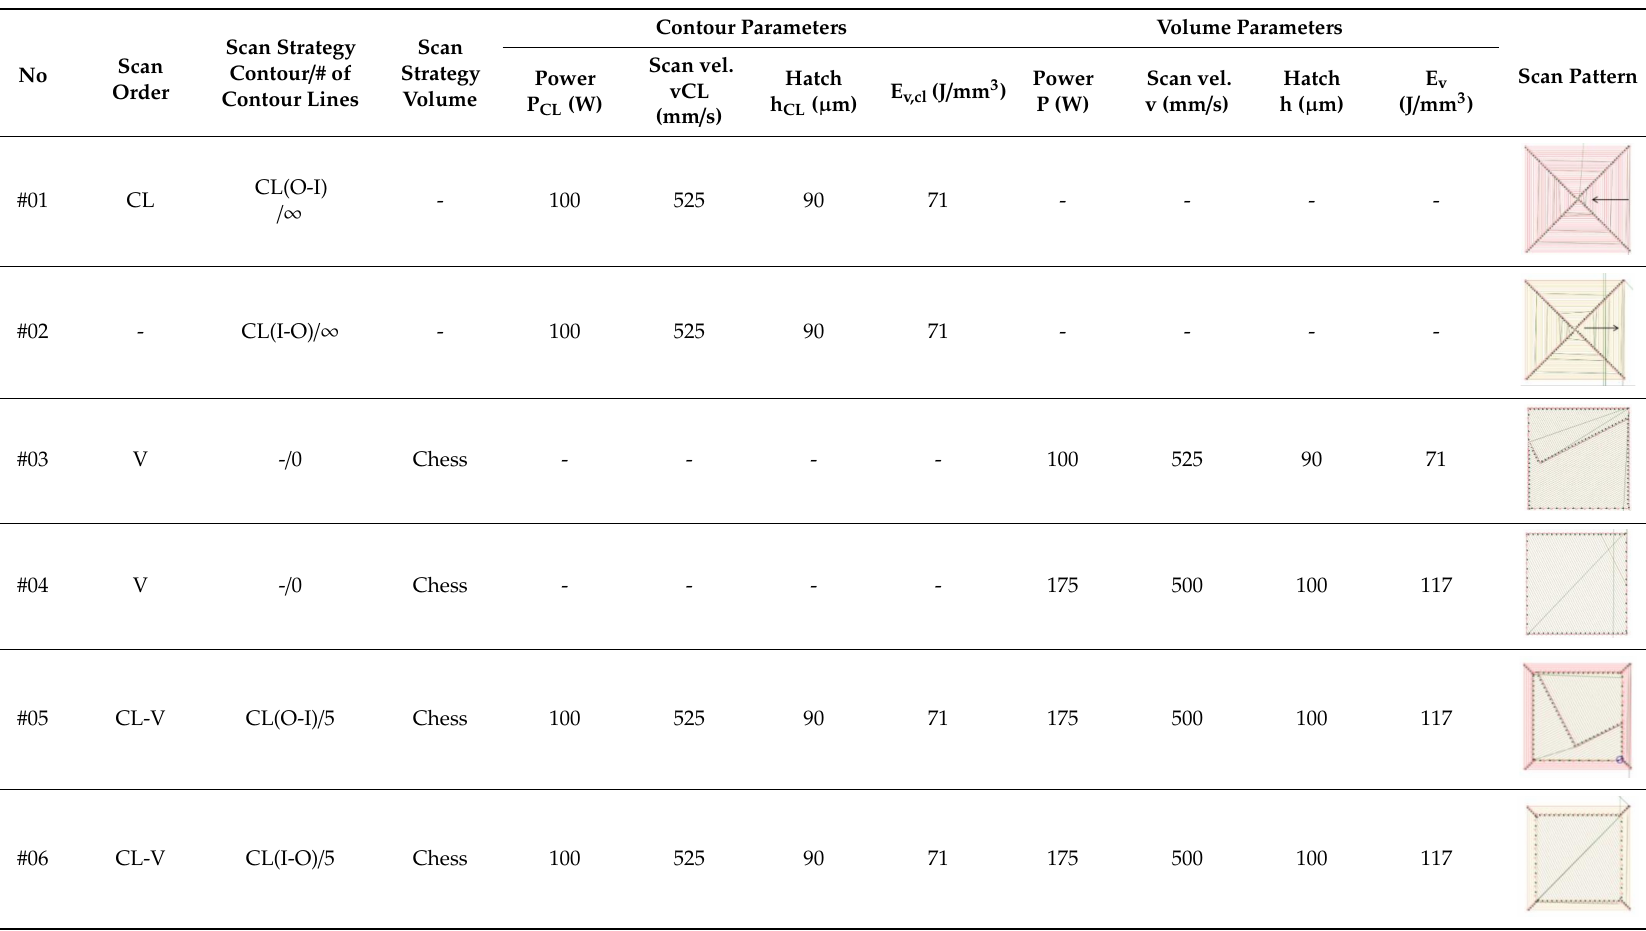
Table A1. Summary of all specimens manufactured with LPBF using di ff erent scan strategies for the current study. Sample #09 corresponds to the SLM Solution standard scan